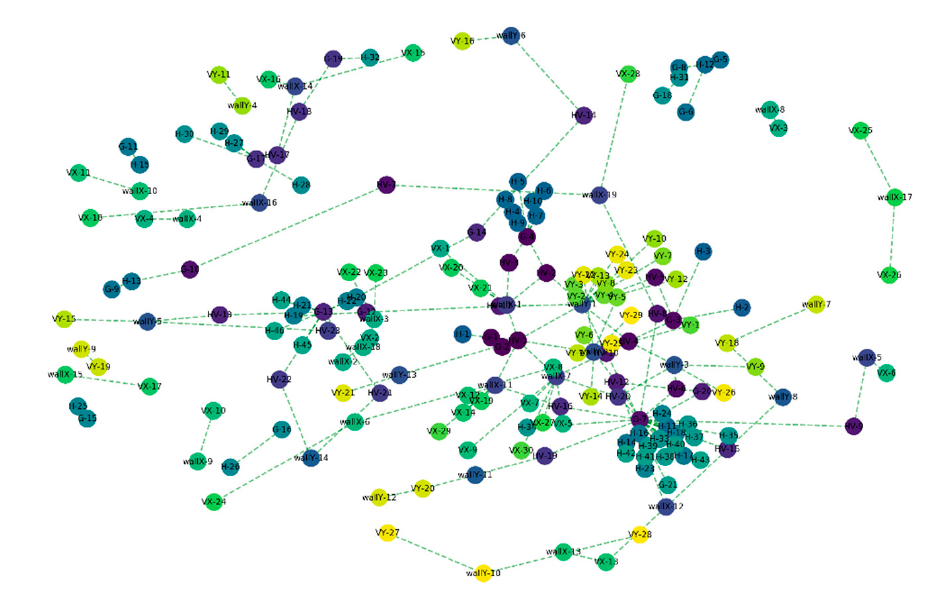
Figure 10. Graph representation within a voxel sample of the point Figure 10: Graph representation within a voxel sample of the point cloud.